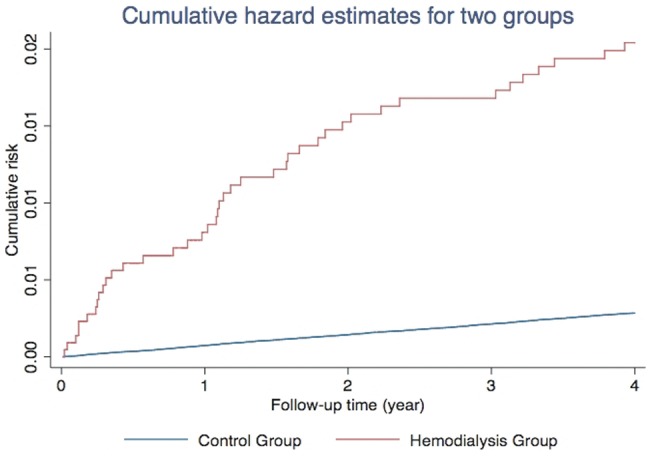
Nelson-Aalen cumulative risk curves.